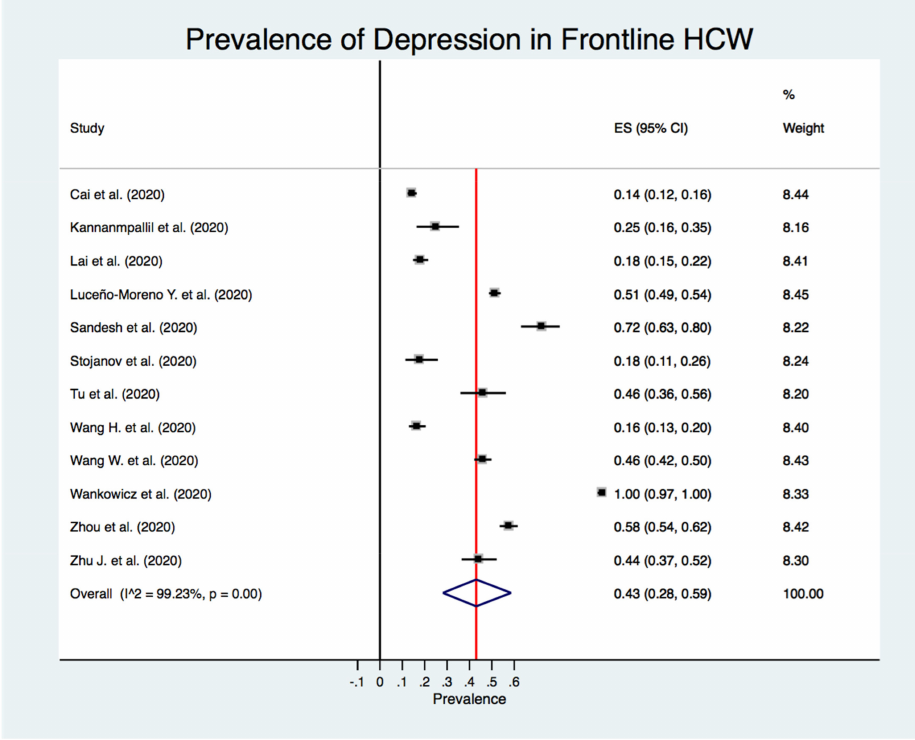
Figure 5. Forest plot for the prevalence of depression among frontline healthcare workers. Potential sources of heterogeneity were investigated across the studies. Our subgroup analysis showed that prevalence of depression was lower in studies using the DASS-21, those carried out in China, studies using convenience sampling methods and those of high methodological quality (Table 5). Table 5. Overall prevalence rates of depression according to study